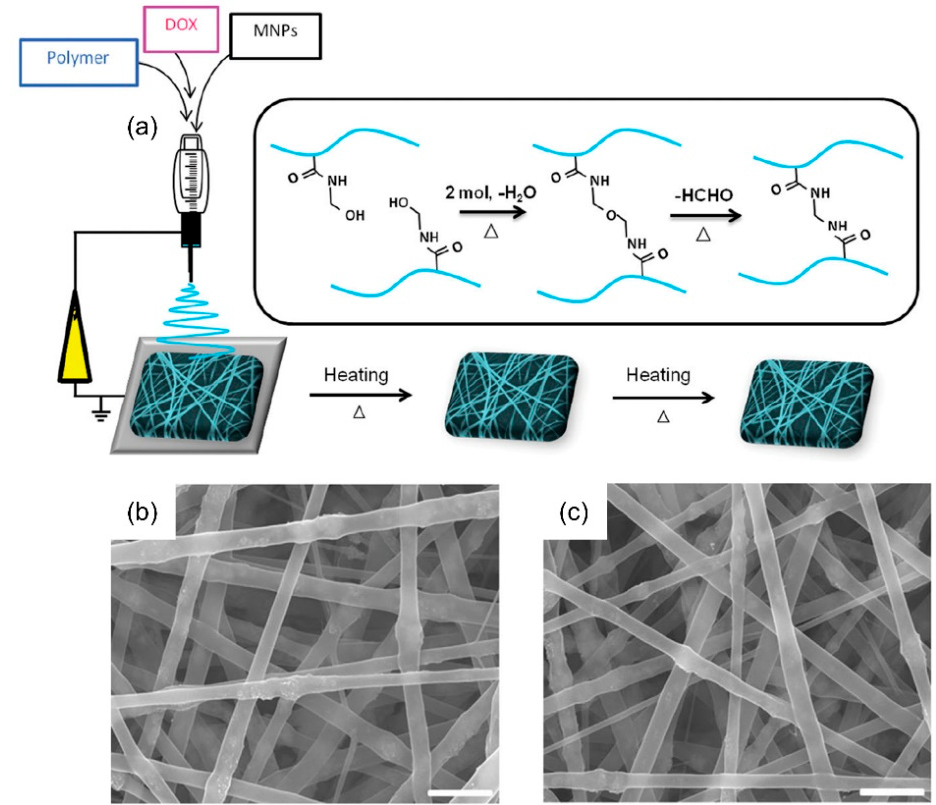
Figure 3. ( a ) Preparation of thermally crosslinkable temperature-responsive NFs by blended elec- trospinning technique. Scanning electron microscopy (SEM) images of DOX/MNP NFs (31 wt% of MNPs and 0.18 wt% of DOX) ( b ) before and ( c ) after crosslinking (scale bars are 1 µm). Reproduced with permission from [51], Copyright © 2021, John Wiley & Sons, Inc.